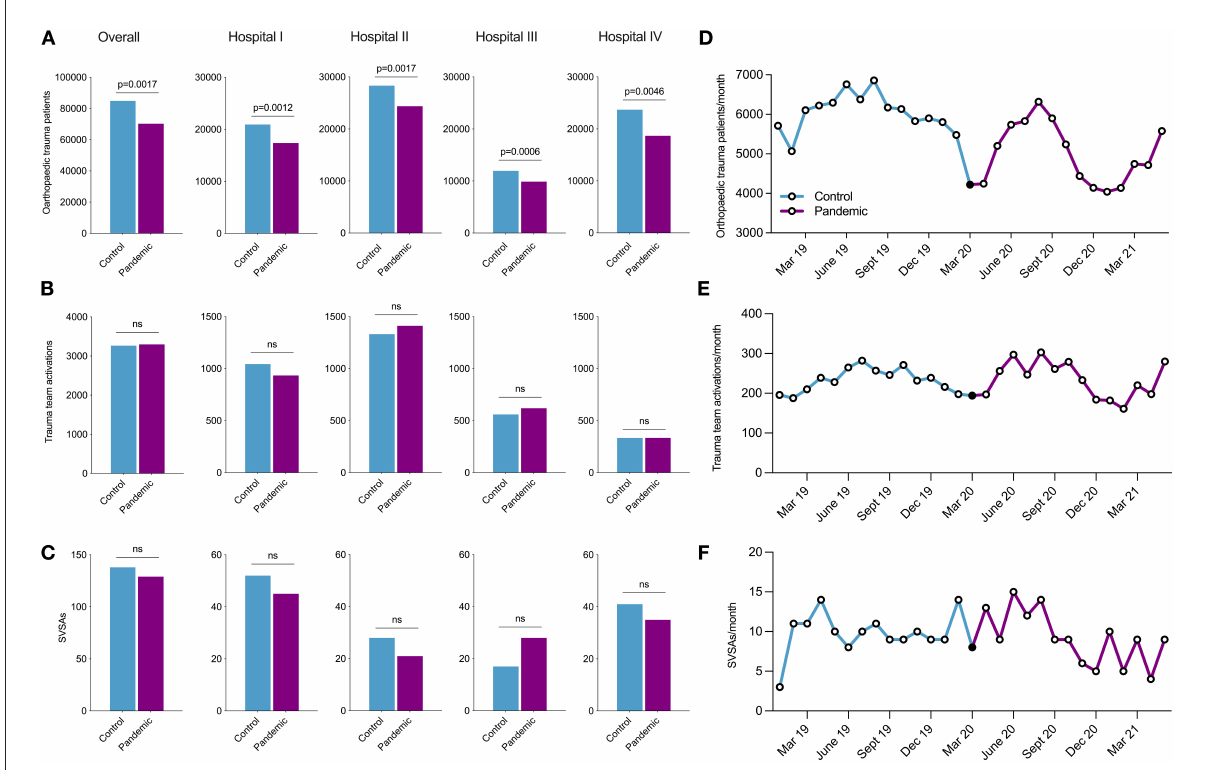
FIGURE2 Overall and hospital-specific distribution of (A) orthopaedic trauma patients, (B) trauma team activations, and (C) SVSAs during the 14-month control (blue) and pandemic period (purple). Longitudinal distribution of (D) orthopaedic trauma patients, (E) trauma team activations, and (F) SVSAs per month during the control (blue) and pandemic period (purple). March 2020 (black dot) was excluded from the analyses. SVSAs, serious violent suicide